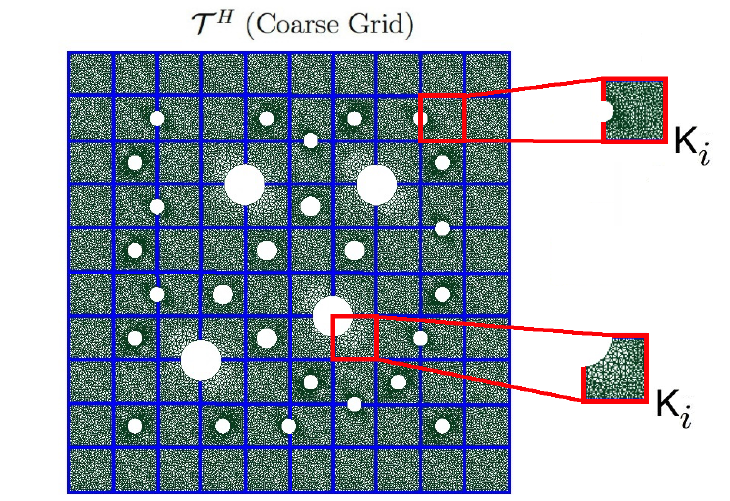
Figure 3. Illustration of a coarse grid and local domain ( K i ) for the Flow